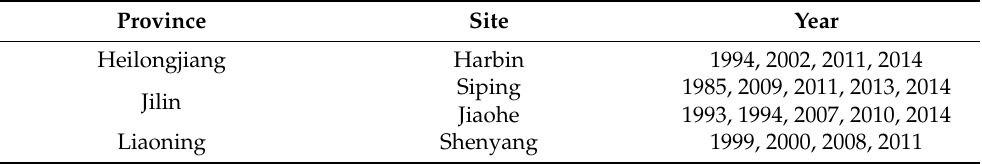
Table 1. Field experimental sites and years of data were used for model calibration and validation in each province.